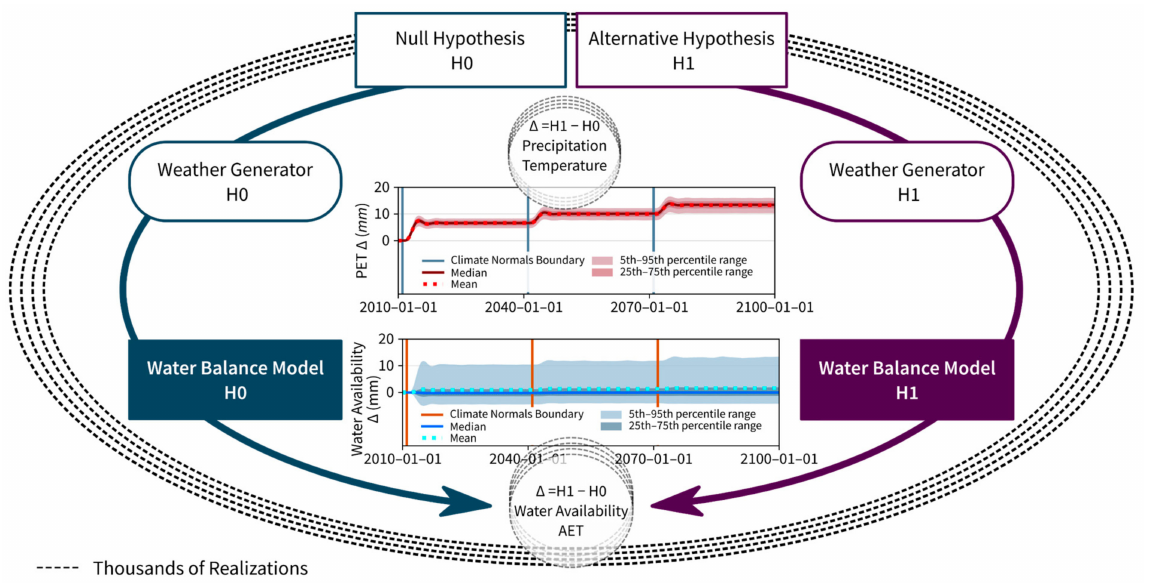
Figure 1. Systemic change, relative impact analysis framework for watershed-scale water resources. Framework results are presented in terms of probabilistic differences, or ∆ s ( ∆ = H1 − H0). Use of ∆ values allows for isolation of impacts on water resources from interference conditions. Potential evapotranspiration (PET) ∆ values are shown as an example. Actual evapotranspiration (AET) ∆ values are provided as results. Adapted from Martin [19] CC BY 4.0.